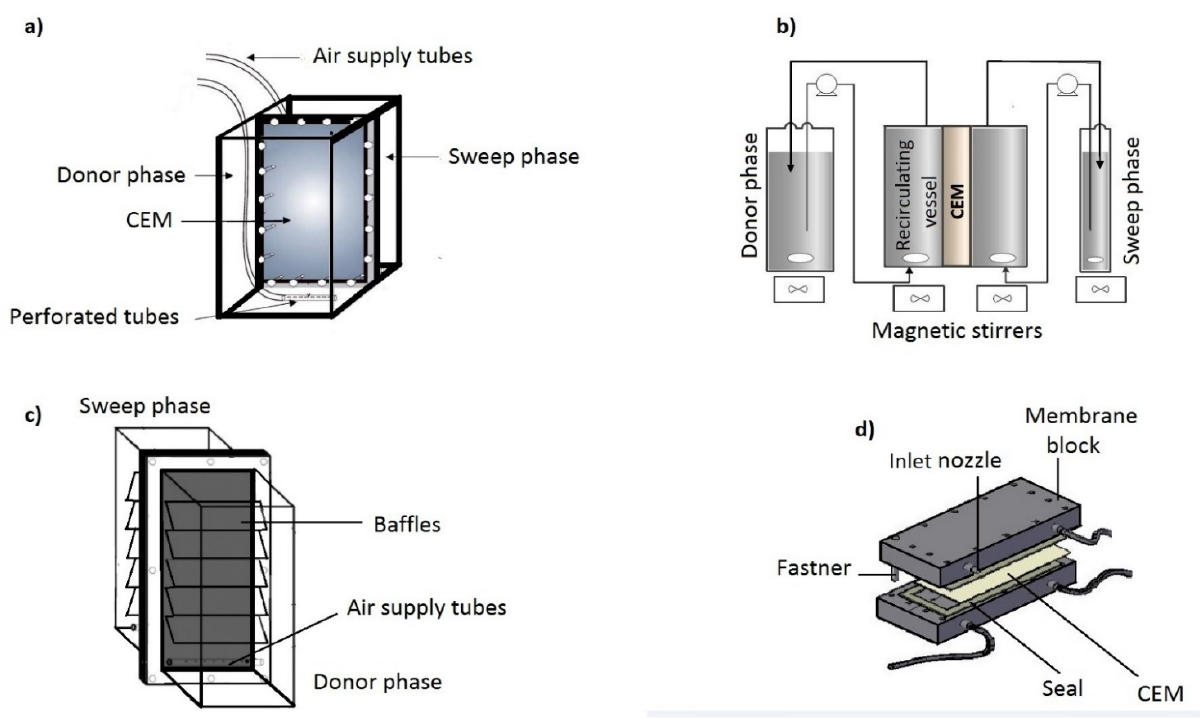
Figure 3. Donnan Membrane Process Cell Designs: ( a ) a simple compartment with compressed air agitation; ( b ) Compart- ment with external vessels and a mixing unit; ( c ) Point of Use systems; ( d ) Donnan membrane rig.